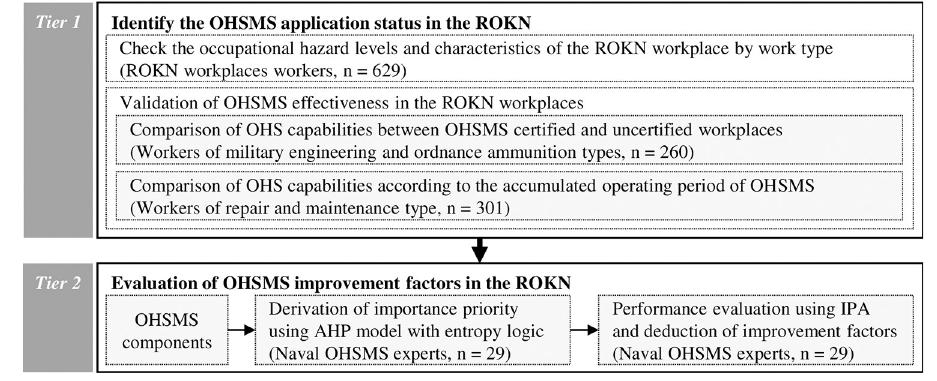
Fig 1. Study framework and